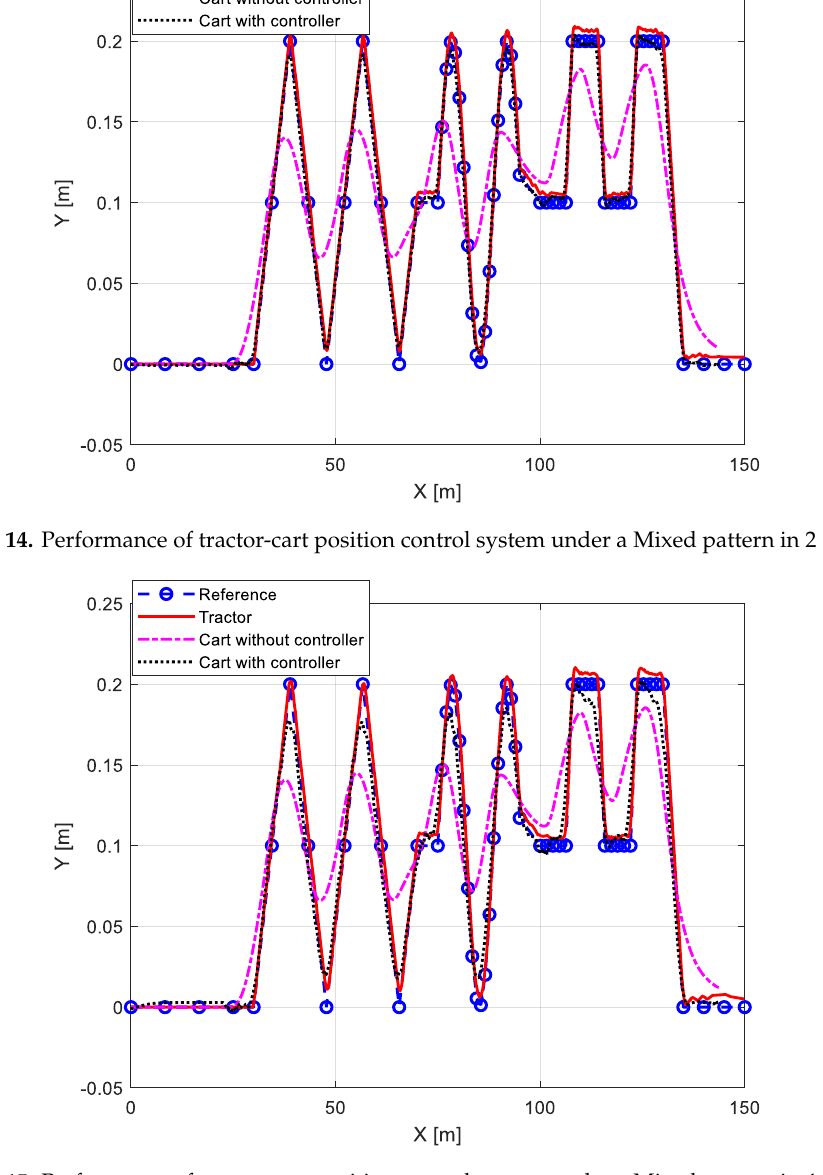
Figure 15. Performance of tractor-cart position control system under a Mixed pattern in 4 [m/s] .